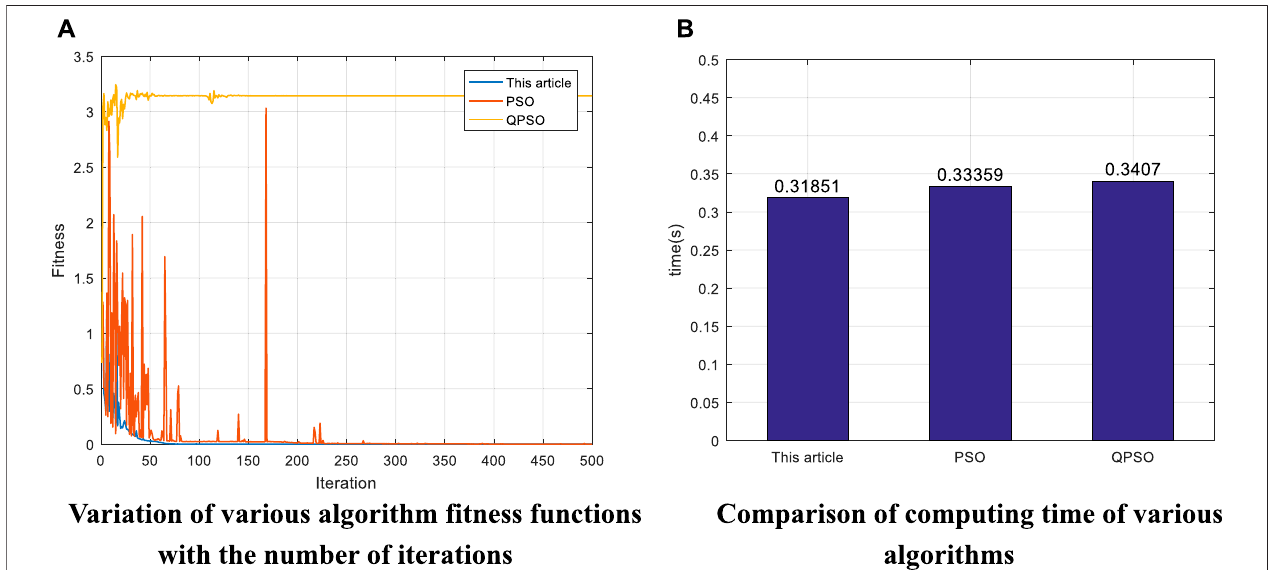
FIGURE 7 | Comparison of the results of various algorithms for the puma560 robot